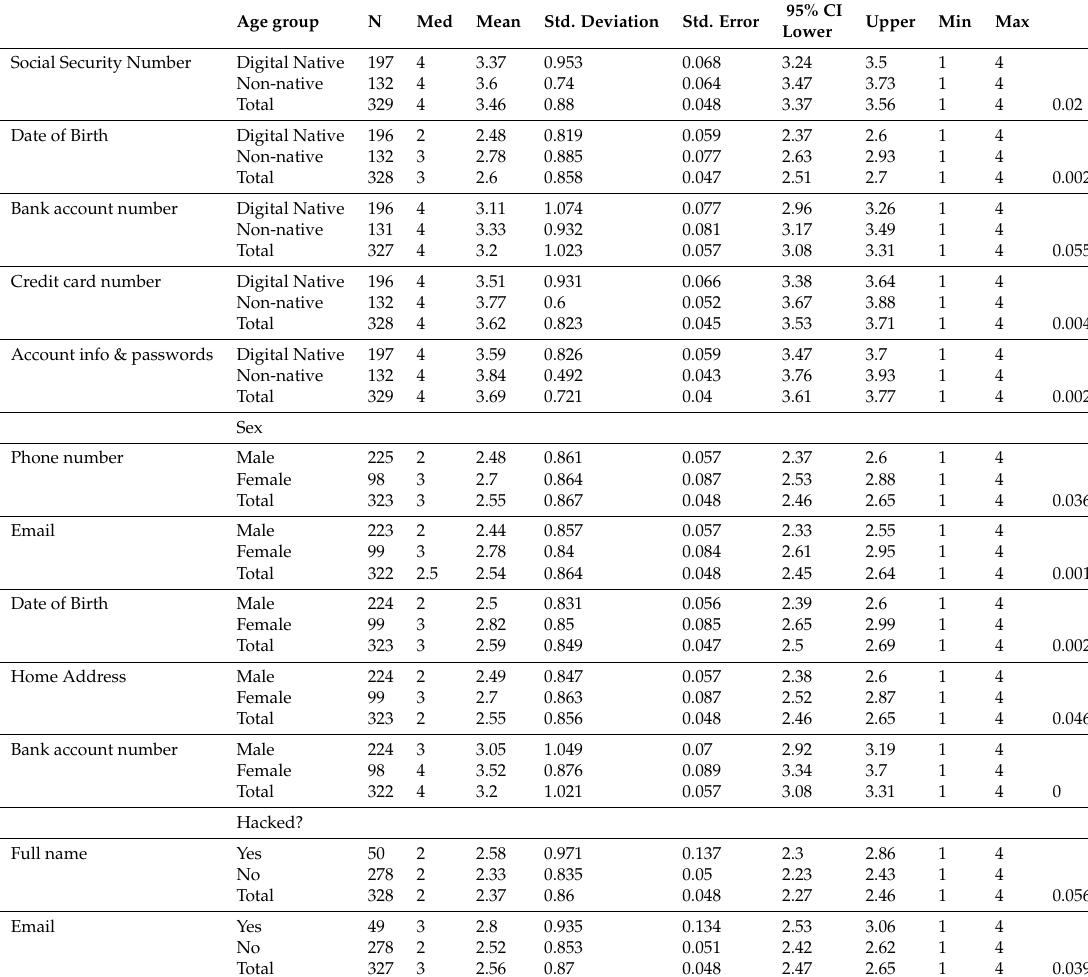
Table 20. Categorical analysis of risk perceptions on information sharing. Age group N Med Mean Std. Deviation Std.